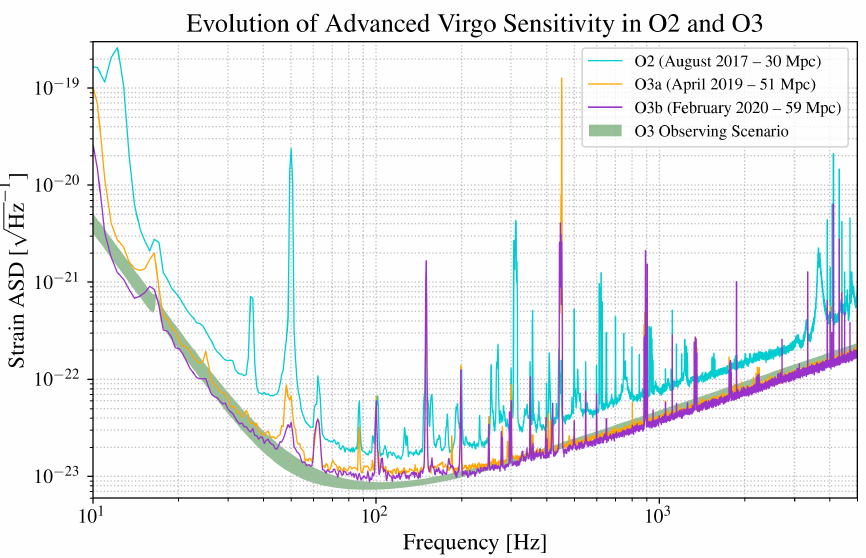
Figure 8. Evolution of the sensitivity curve h ( f ) of the Advanced Virgo detector in its Observing Runs, and comparison to the design sensitivity for Virgo (Observing Scenario [145]).